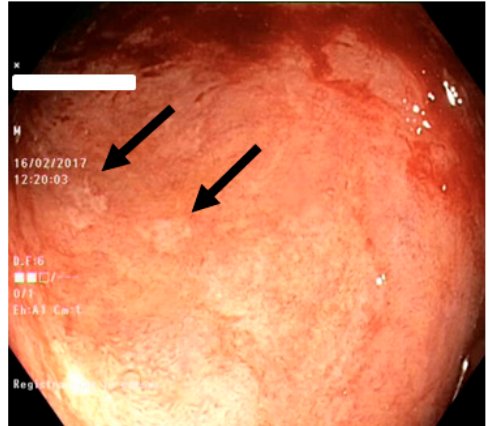
Figure 3. Ulcers in active ulcerative colitis (black arrows): mucosal breaks with fibrin spots within the hyperemic and friable mucosa and disappearance of the vascular pattern.